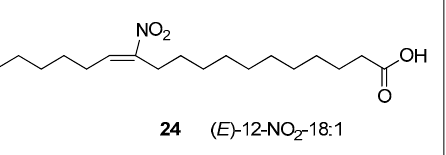
Figure 7. Structure of the optimum activator of PPAR γ reported by Gorczynski [74].